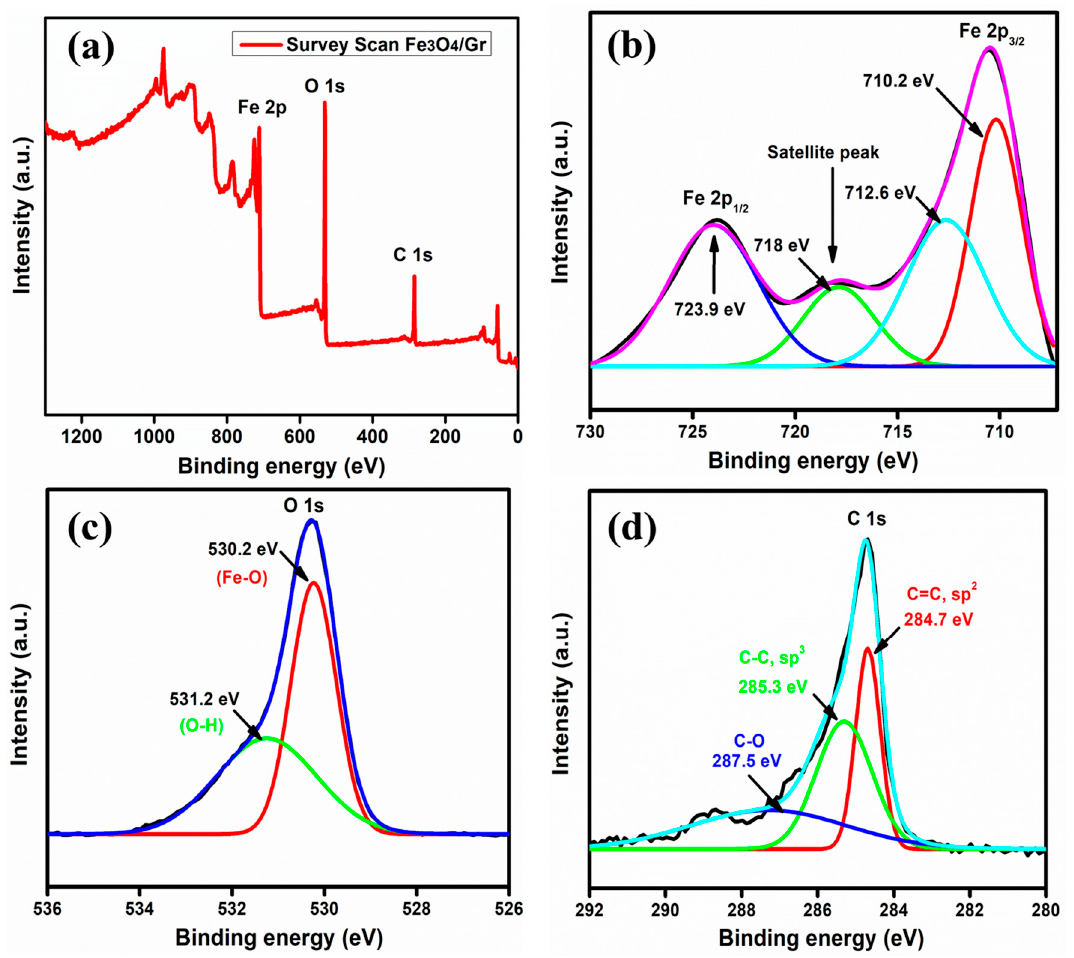
Figure 4. XPS spectra of Fe 3 O 4 /Gr nanocomposite. ( a ) Survey scan, ( b ) Fe 2p 3/2 and Fe 2p 1/2 , ( c ) O 1s, and ( d ) C 1s spectra.